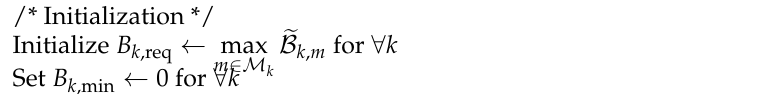
Algorithm 1 Proposed feedback bits allocation